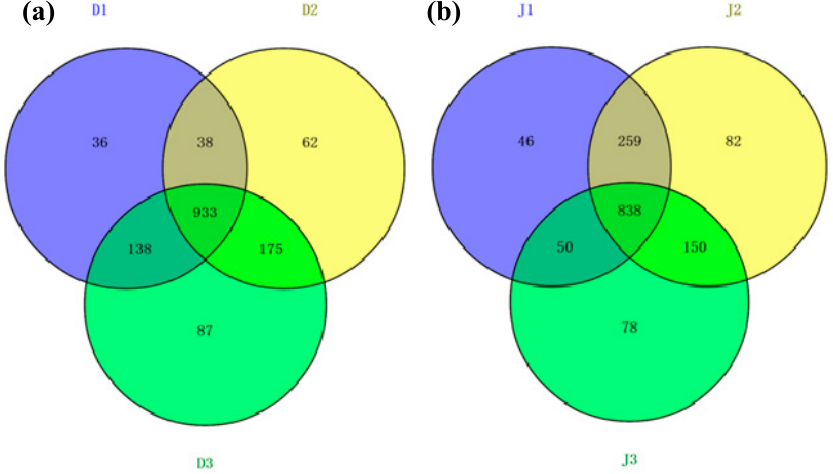
Figure 5. Shared OTUs analysis of bacterial 16S rRNA gene libraries of the samples in ( a ) sewage creek; ( b ) industry creek.